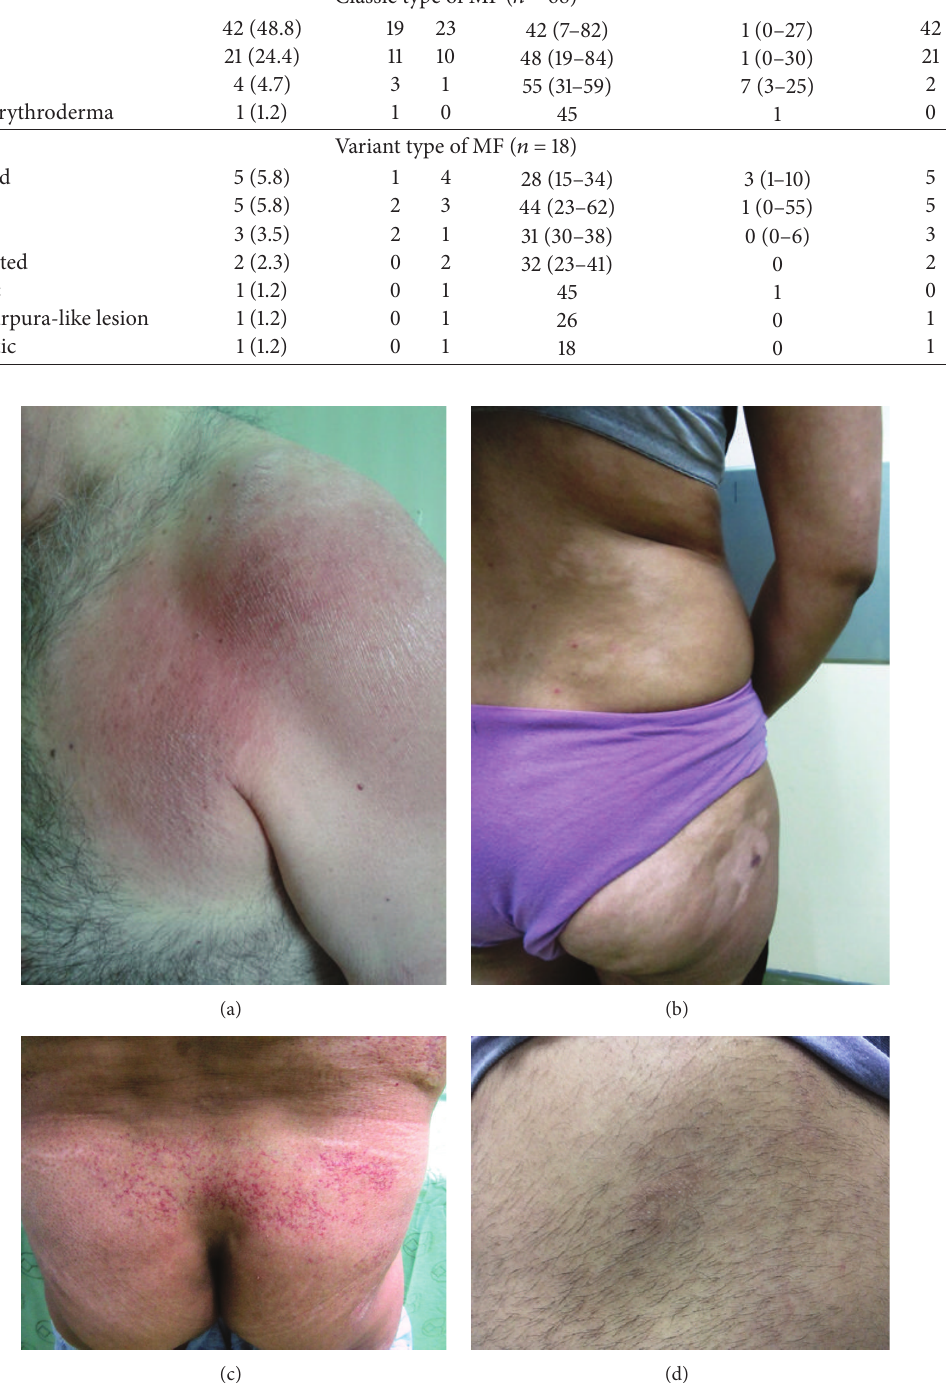
Figure 1: (a) Classic mycosis fungoides. Erythematous mildly scaly patch in the upper trunk. (b) Hypopigmented mycosis fungoides. Multiple hypopigmented and ill-defined to well-defined patches were seen on the back and thigh. (c) Poikilodermatous mycosis fungoides. The lesions arecharacterizedbyhypopigmentationandhyperpigmentationwithatrophyandtelangiectasia.(d)Folliculotropicmycosisfungoides.Diffuse perifollicular inflammatory papules coalescing into